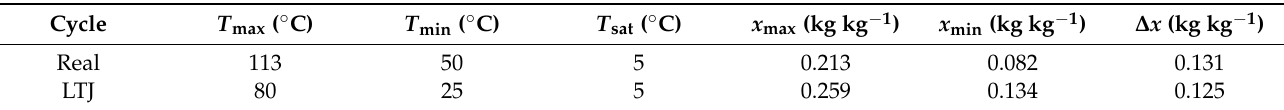
Table 3. Real cycle conditions vs. LTJ conditions for adsorption.